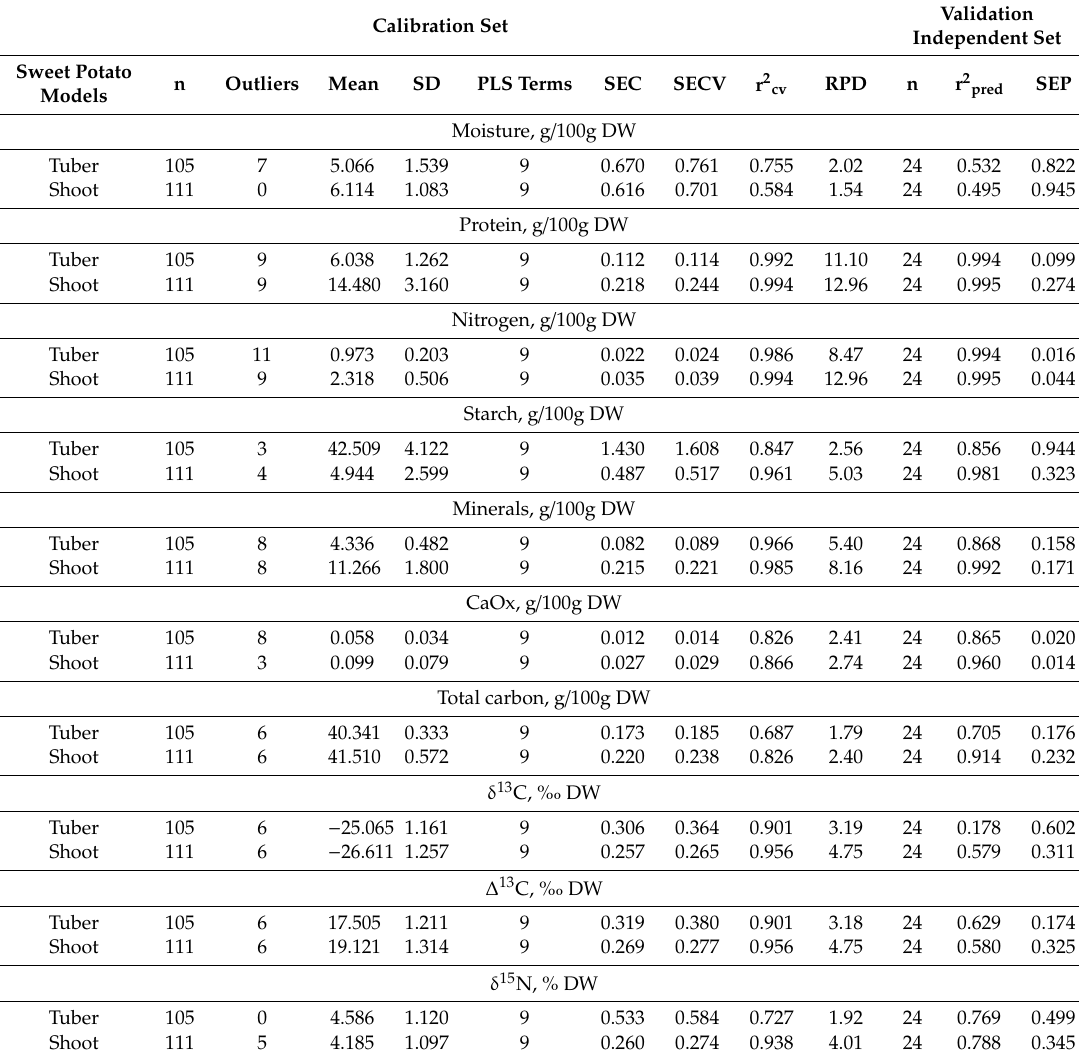
Table 3. Quality constituent statistics for calibration and independent validation models of sweet potato ( Ipomoea batatas (L.) Lam.) accessions flour under drought conditions. Calibration Set